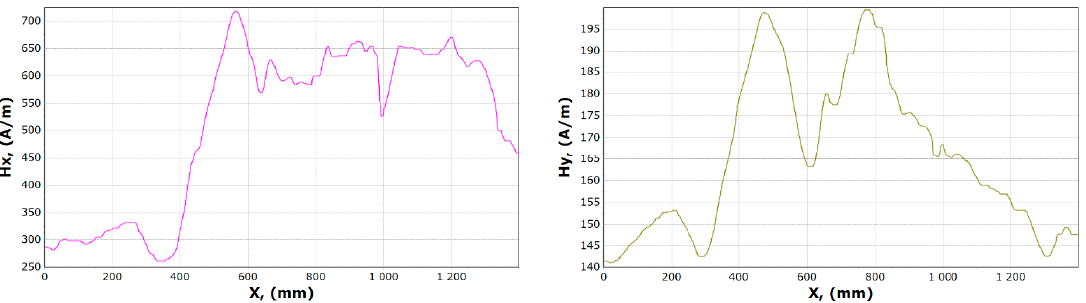
Figure 15. Graphs of tangential Hx and normal Hy component of the magnetic field, for sample 23.